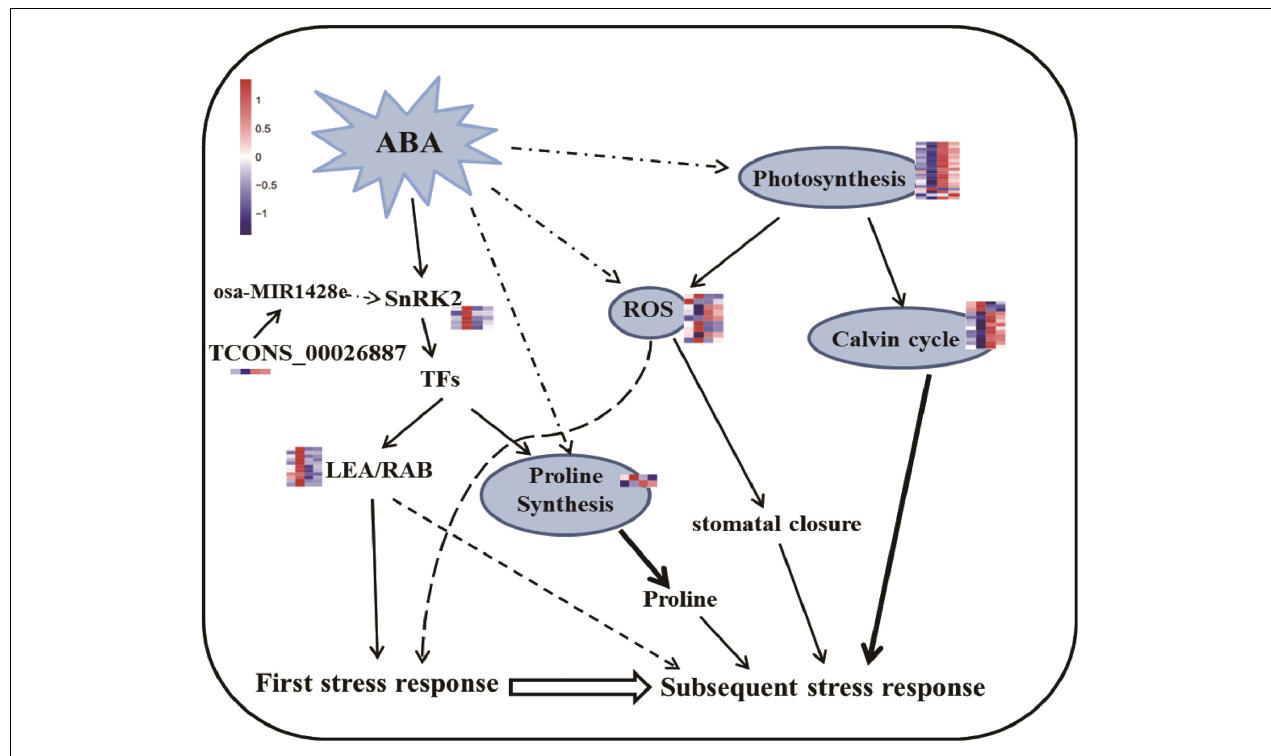
FIGURE 8 | Predicted pathways for regulating rice drought memory response. The ABA/SnRK2-mediated pathway actives downstream genes in response to the first drought stress. ABA might act as memory factor to regulate genes related to photosynthesis, proline synthesis and ROS repair, result in accumulation of protective substances (such as proline) to respond to subsequent drought stress. During this process, TFs might also take part in regulating proline synthesis to accumulate proline. Broken lines indicate possible, but not confirmed, routes. Full lines represent the routes have been demonstrated in previous studies. Heatmap of memory transcripts involved in these pathways are